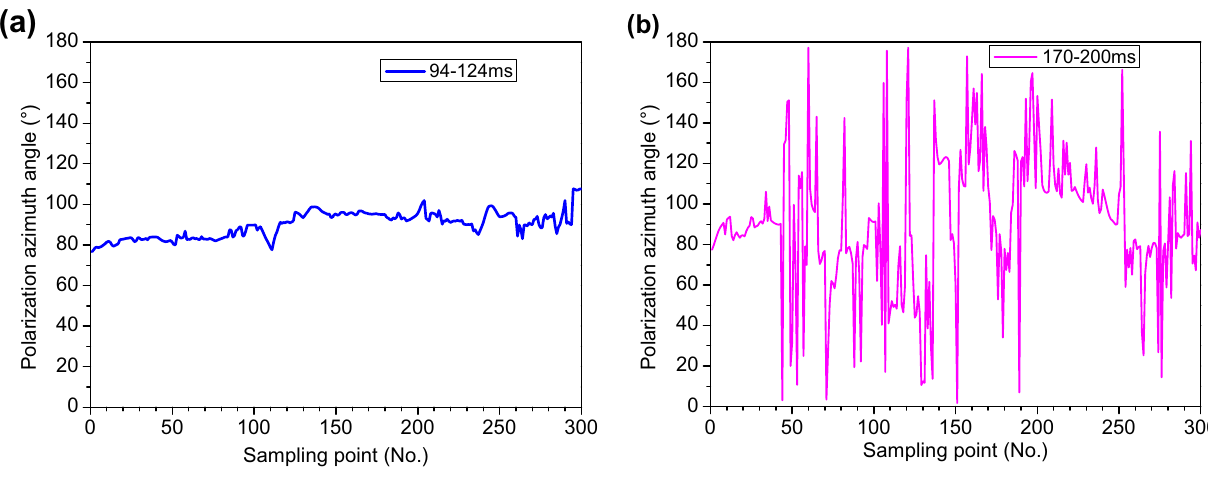
Fig. 9 Polarization azimuth angles of the records in Receiver No. 11 of the 11th single shot: a 94–124 ms, b 170–200